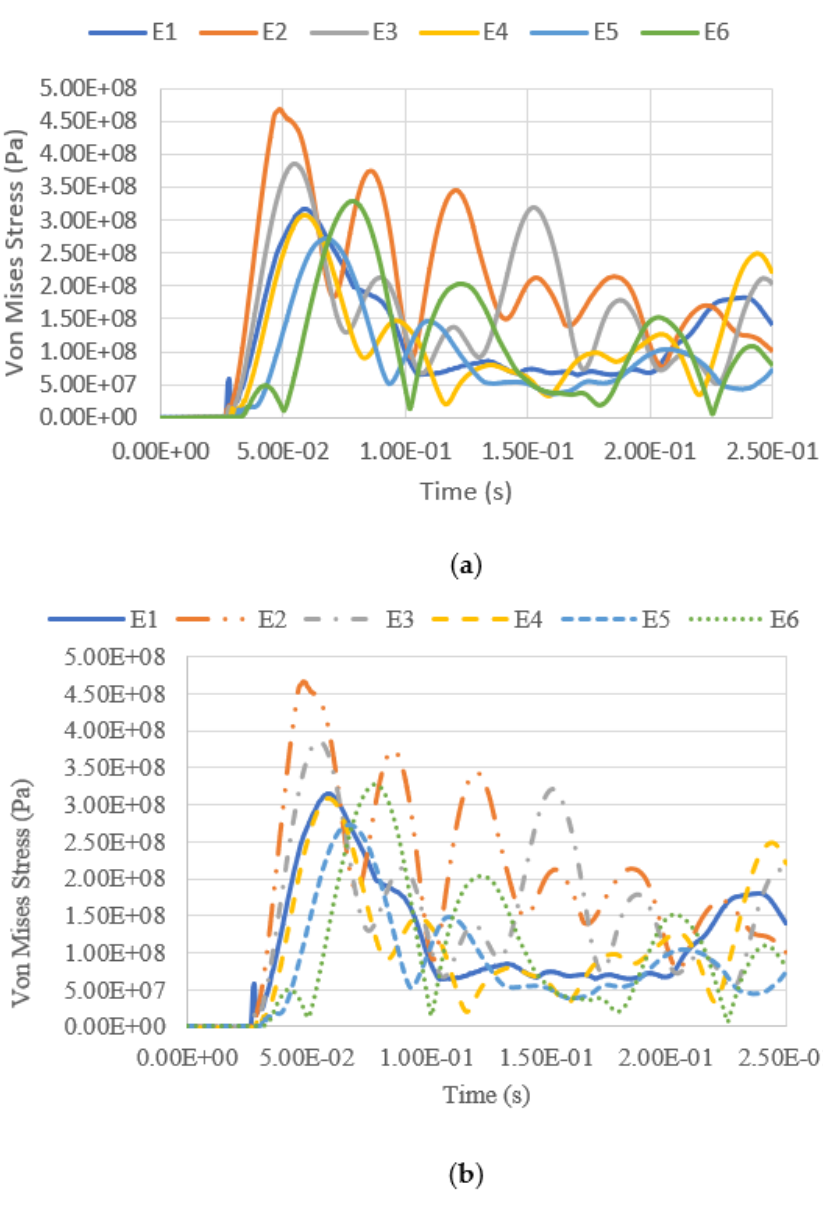
Figure 20. Equivalent stress versus time under blast intensity of 1500 kg TNT equivalent mass 25 m away, ( a ) 100% fill and ( b ) 0% fill .